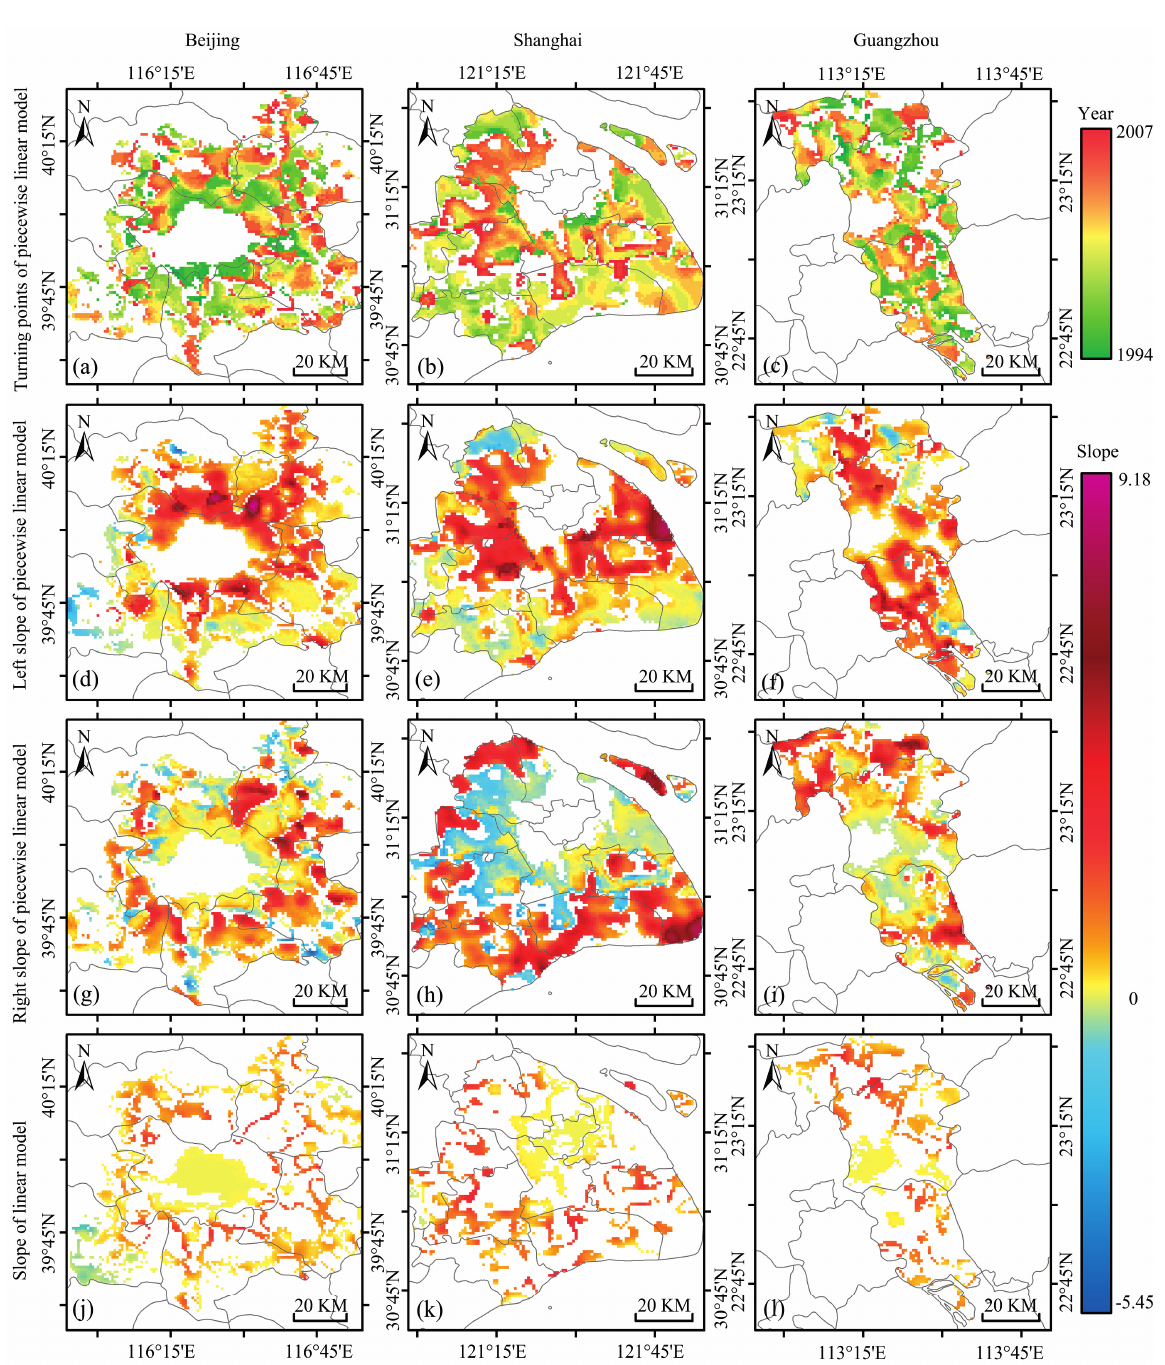
Figure 5. Spatial distribution of parameters of piecewise linear model and linear model in Beijing (left column), Shanghai (center column) and Guangzhou (right column): turning points ( top row , ( a – c )), left slope ( second row , ( d – f )) and right slope ( third row , ( g – i )) of piecewise linear model and slope of linear model ( fourth row , ( j – l )). In (d) to (l) yellow color is adjusted to represents parameter values of